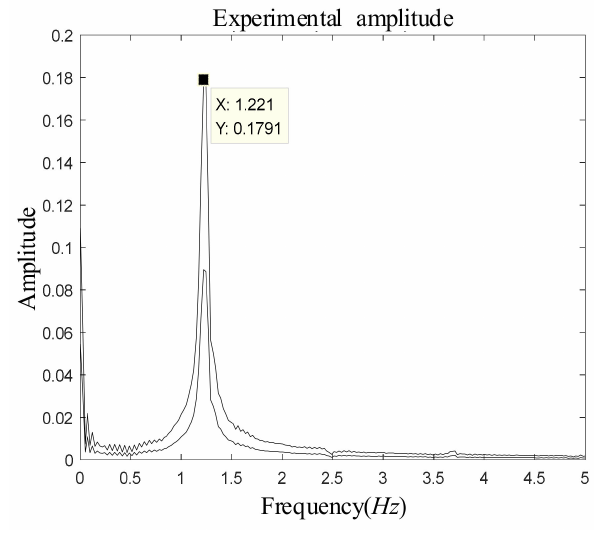
Figure 16. Frequency response curve of the flexible arm.